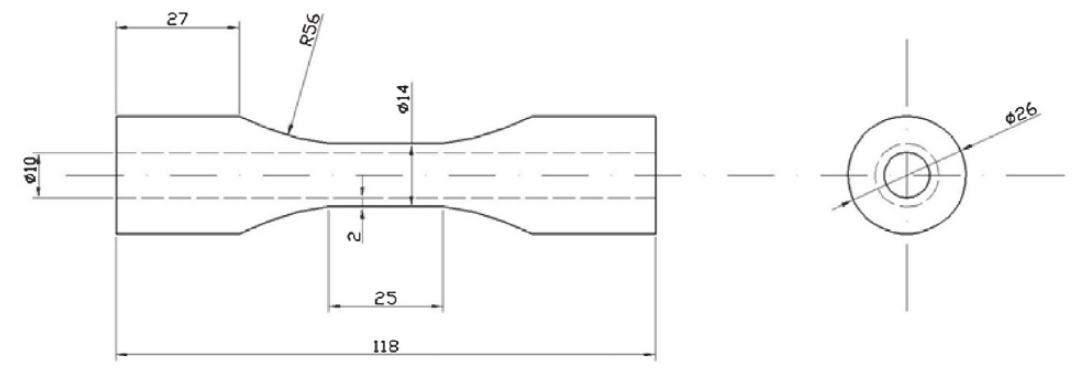
Figure 1: Geometry of the tubular hollow specimen used in the experiments. All dimensions are in